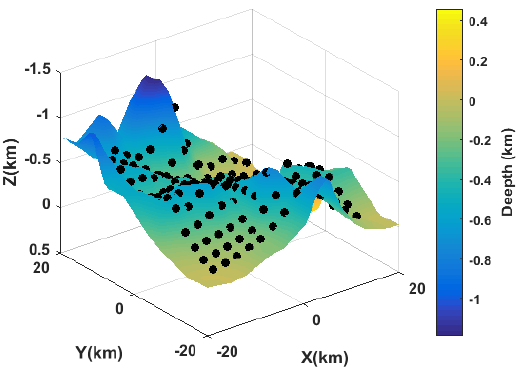
Figure 18. The topography in the inversion domain (with exaggeration in the vertical direction). The black dots indicate the MT receivers.